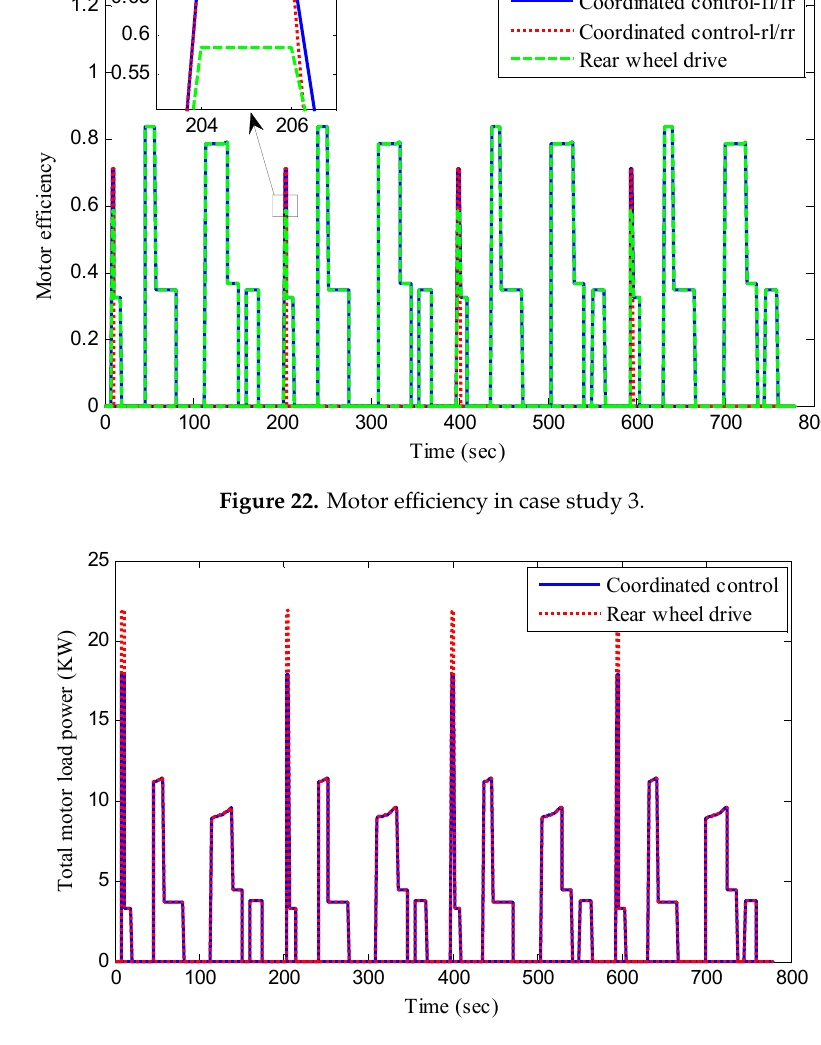
Figure 23. Total motor load power in case study 3.